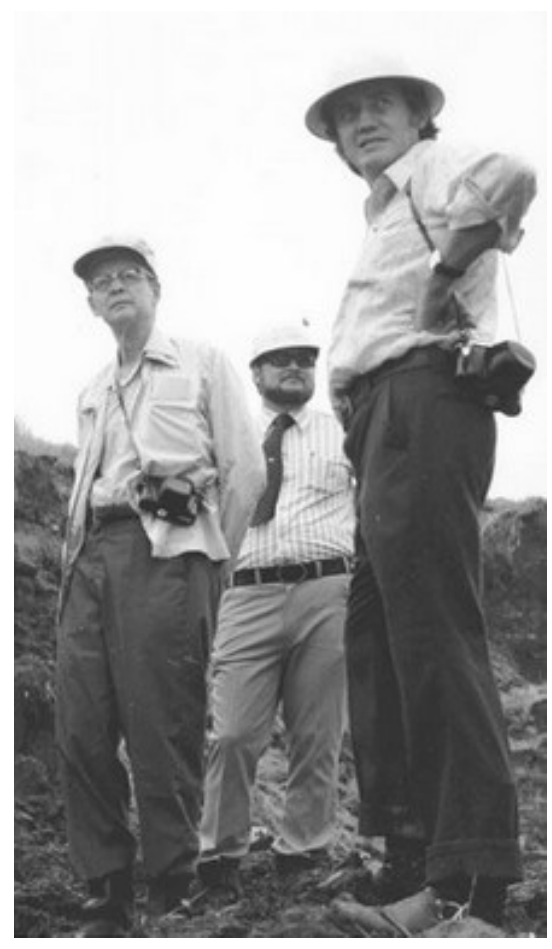
Figure 8. Arthur Casagrande (first left) on a visit to the Panama Canal, in